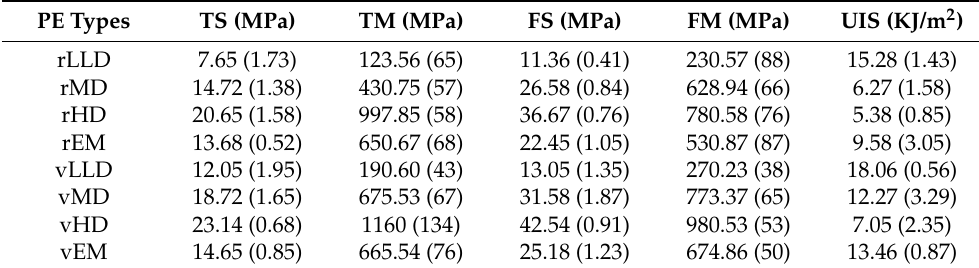
Table 7. Mechanical properties of the virgin and recycled PE (LLD, MD,